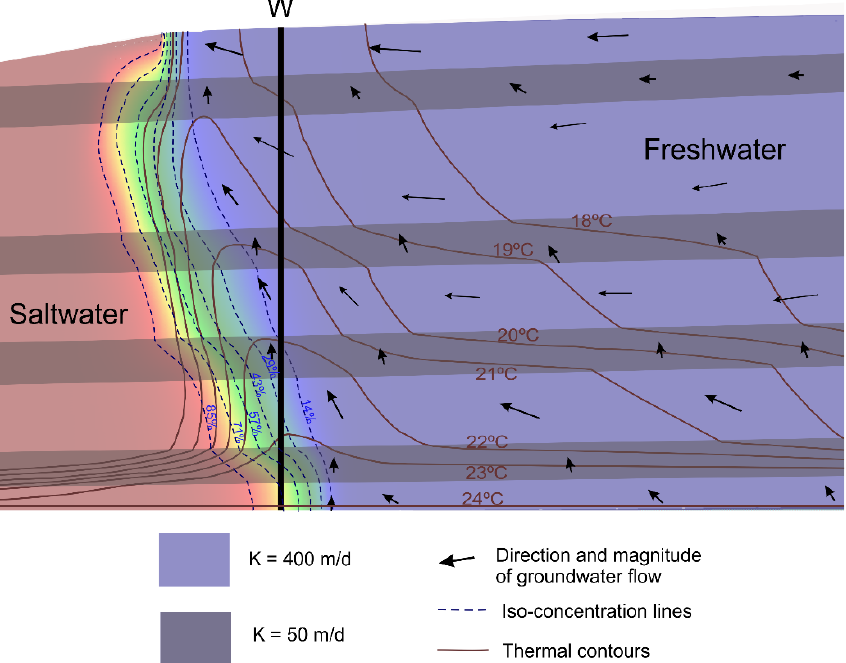
Figure 10. Salinity and temperature distribution resulting from the multilayered model (model B).